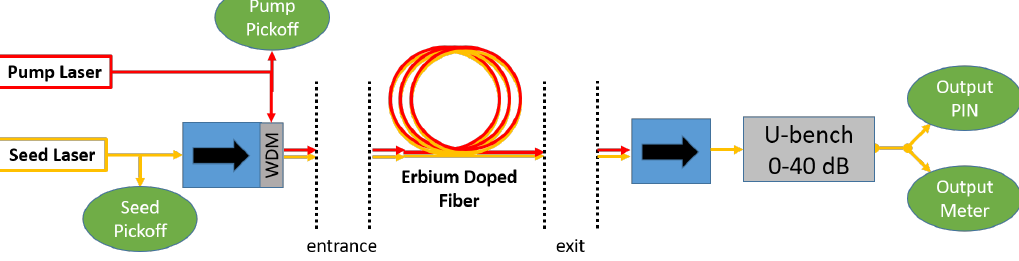
Figure 11. The setup used for characterizing the FLAT. The optics before the entrance and after the exit of the erbium doped fiber were kept the same except the free-space attenuation on the U-bench. The erbium doped fiber was swapped out after a series of measurements at different pump power were